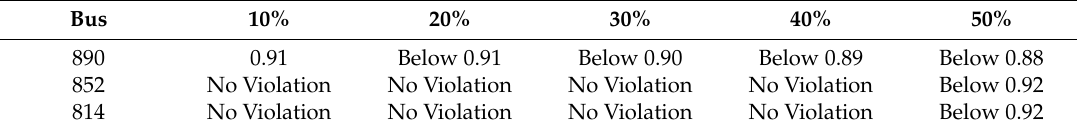
Table 8. Case 4 Maximum Charging Load kW during Peak Hours.